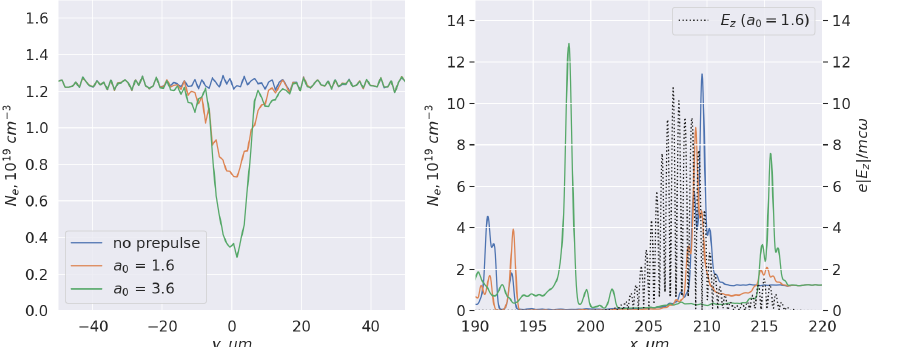
Figure 6. Lineouts of electron density in cross-sections x = 212 µ m ( left ) and y = 0 ( right ) at time instants t = 759 fs in cases with different prepulse amplitudes a 0 . On the right the shape of the laser pulse in the case of a 0 = 1.6 is shown for